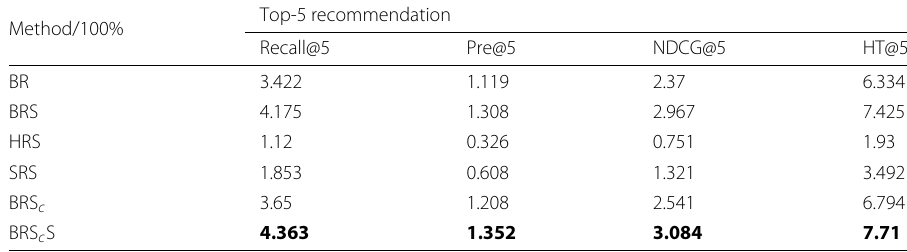
Table 2 Experiment I of top-5 recommendation